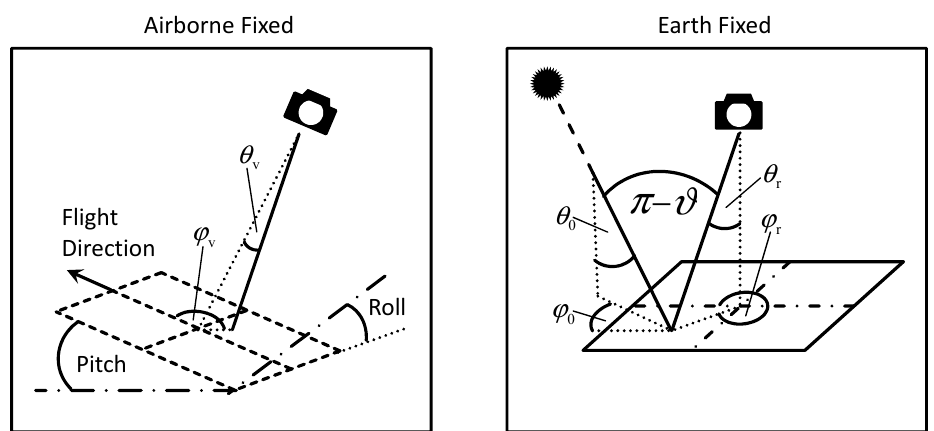
Fig. 4. Illustration of the airborne fixed (left, θ v , φ v ) and Earth fixed coordinates (right, θ r , ϕ r ) of one single camera pixel. Additionally, the scattering angle ϑ is indicated with the position of the Sun defined by θ 0 , φ 0 .